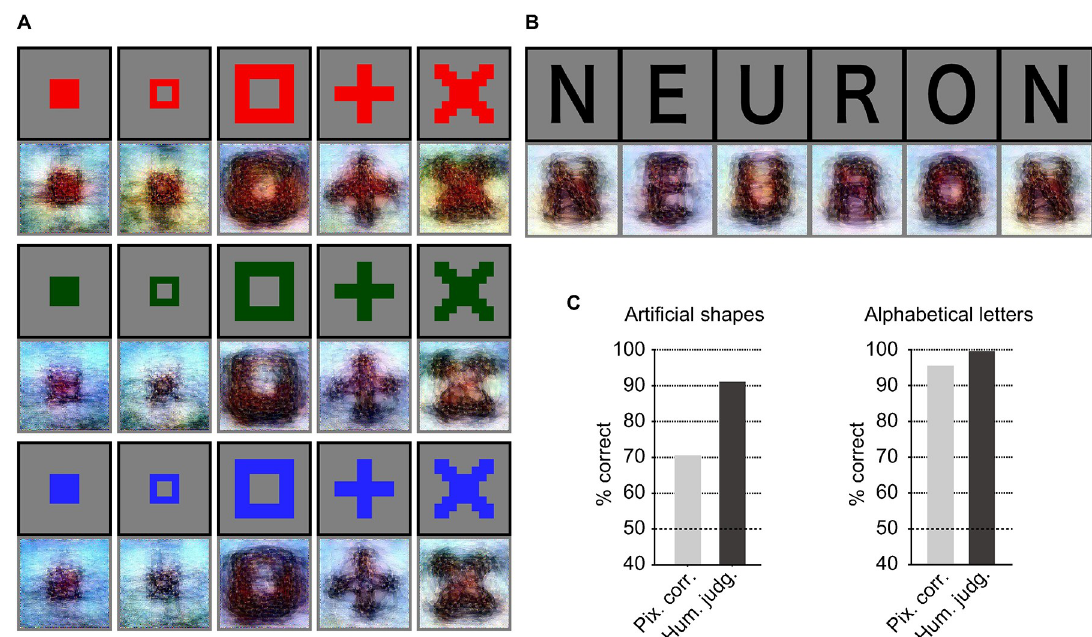
Fig 6. Seen artificial image reconstructions. The black and gray surrounding frames indicate presented and reconstructed images respectively (VC activity, DNN 1–8, without the DGN). ( A ) Reconstructions for seen artificial shapes. ( B ) Reconstructions for seen alphabetical letters. The reconstructed letters were arranged in the word: “NEURON”. ( C ) Reconstruction quality of artificial shapes and alphabetical letters (three subjects pooled, N = 120 and 30 for artificial shapes and alphabetical letters, respectively; chance level, 50%).